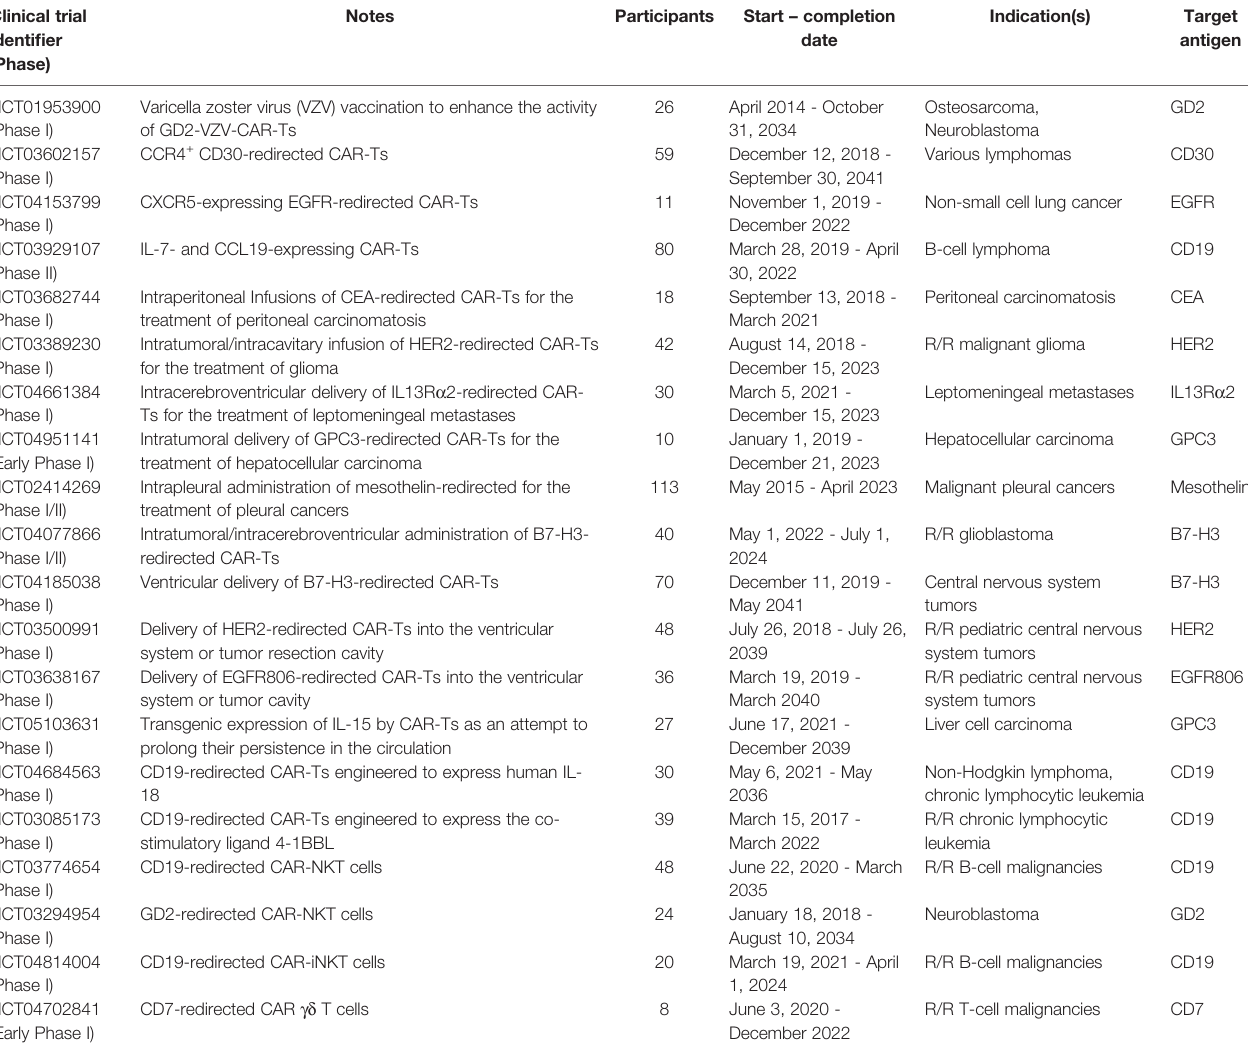
TABLE 1 | A summary of the advances in solid tumor CAR-T therapy investigated in clinical trials. Clinical trial identi fi